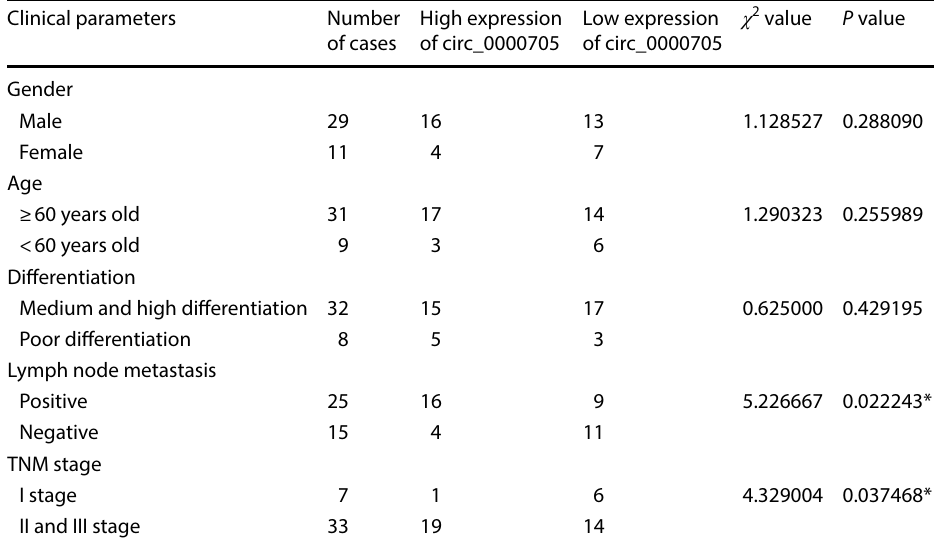
Table 2 Relationship between circ_0000705 expression and clinical parameters in 40 clinical ESCC tissue